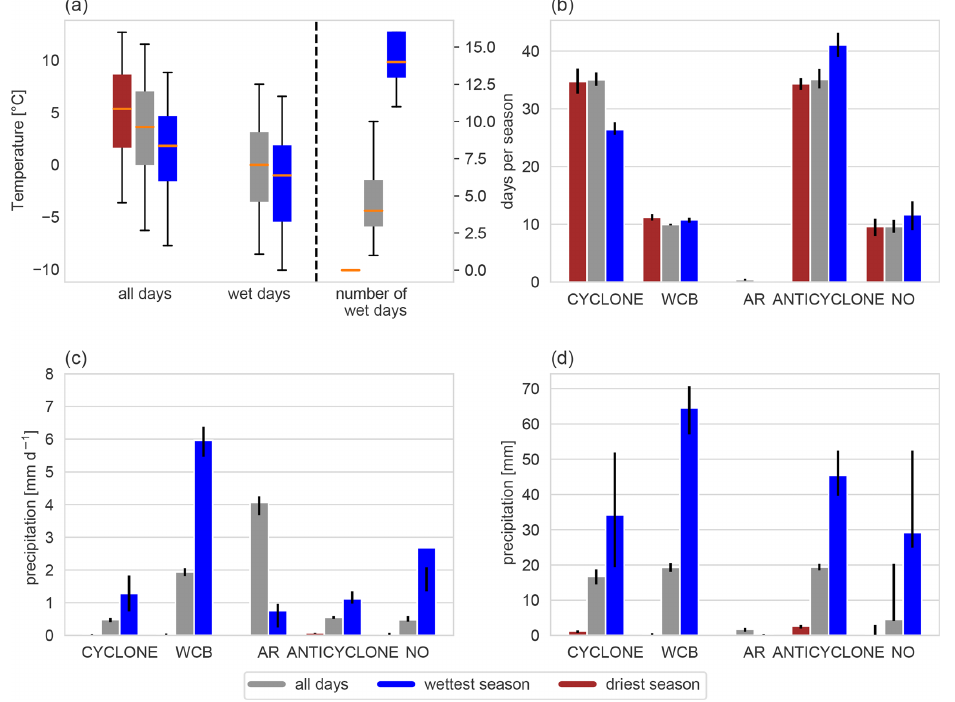
Figure 11. Same as Fig. 9 but for winter in